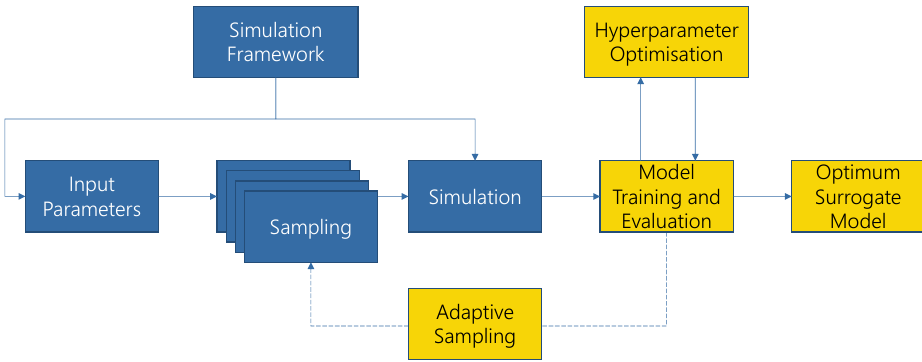
Figure 2. Basic emulation or surrogate/meta-model workflow based on the literature review.